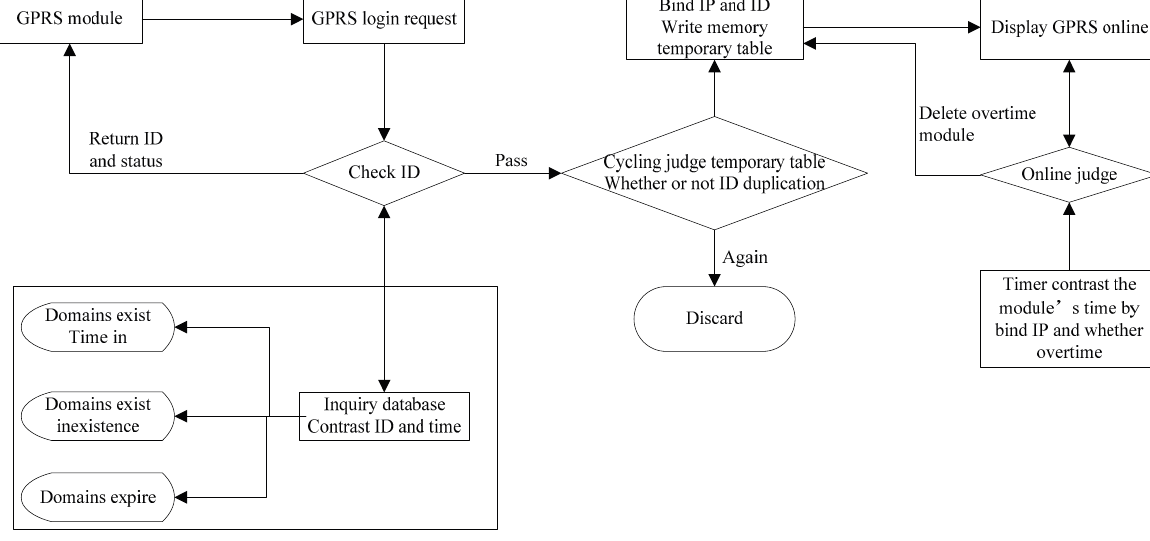
Figure 5. The workflow of the LAIS